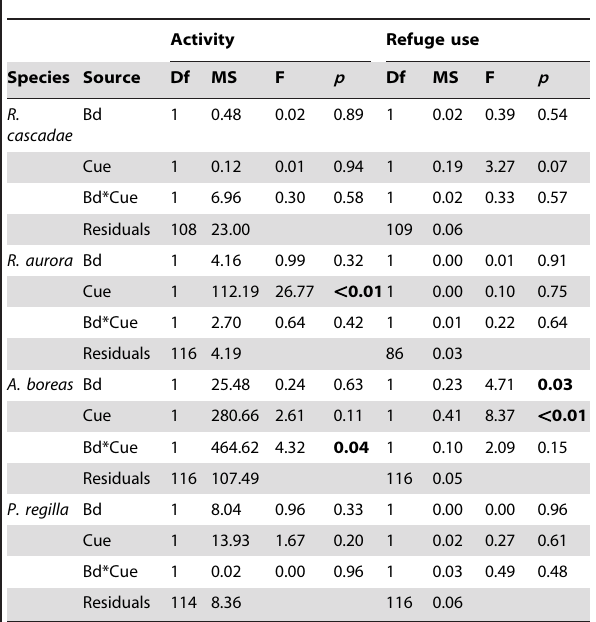
Table 1. Two-way ANOVA tables for activity (mean number of gridlines crossed/30 sec) and refuge use (the mean number of times animals were observed using refuge/30 sec) for larvae of four amphibian species in a 2 6 2 factorial design with two cue treatments (predator, neutral), and two exposure treatments to Batrachochytrium pathogen (Bd + and Bd 2